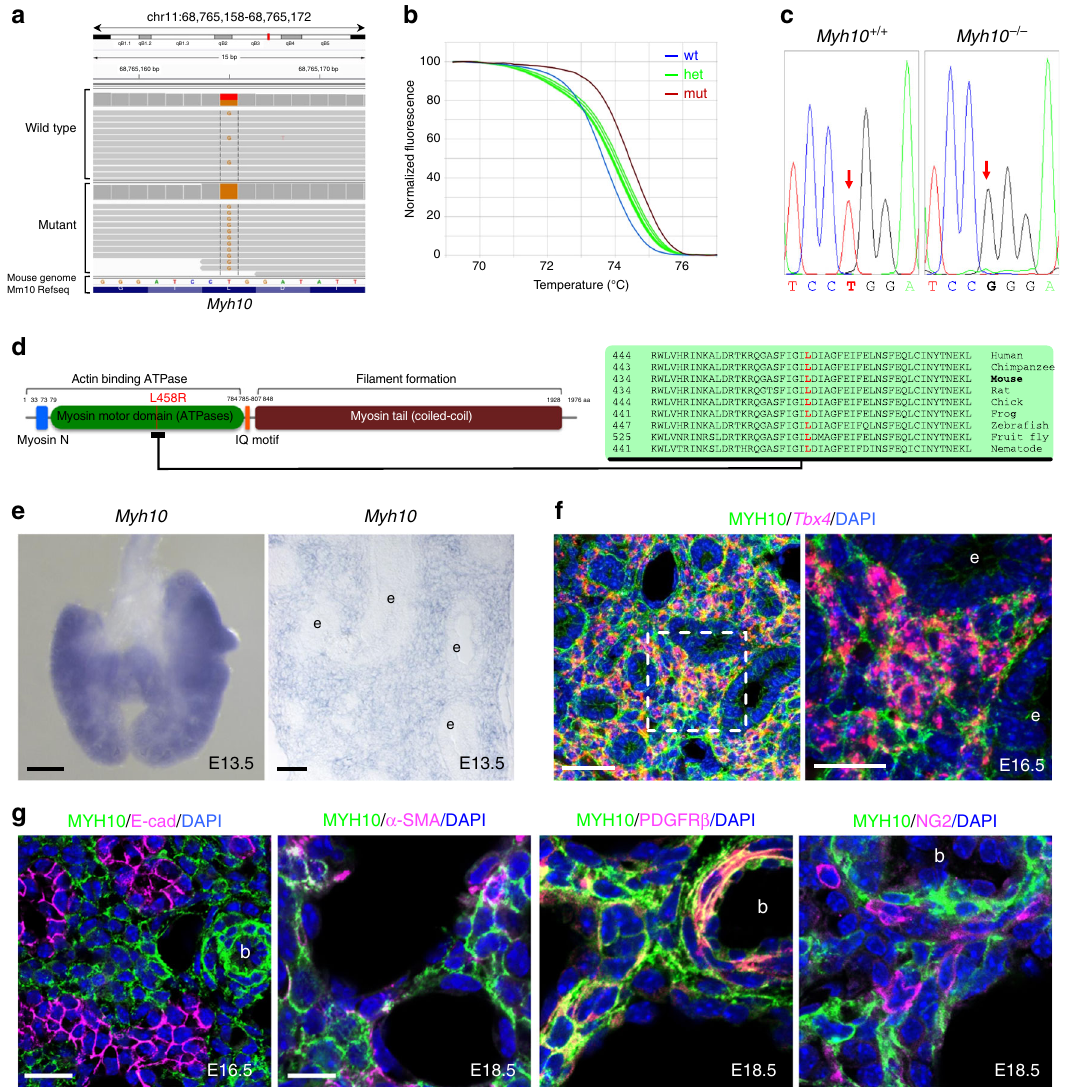
Fig. 2 Isolation of the causative lesion and expression pattern of Myh10 . a Integrative genomics viewer (IGV) snapshot of the c.T1373G mutation in Myh10 (chr 11:68,765,165). b Normalized melting curves showing the Myh10 mutation by high-resolution melting analysis (HRMA). c Chromatogram of two different genotypes of Myh10 by Sanger sequencing. d Schematic diagram of MYH10 protein domains and the relative position of the L458 residue, which is conserved from worms to humans. e In situ hybridization for Myh10 expression in E13.5 whole-mount and on cryosectioned lungs; e epithelium. f Double staining for Tbx4 mRNA (red) and MYH10 protein (green) on E16.5 lung sections; e epithelium. g Immunostaining for MYH10, E-cadherin (marking epithelial cells), α -SMA (marking myo fi broblasts and smooth muscle cells), PDGFR- β (marking myo fi broblasts and smooth muscle cells), and NG2 (marking pericyte-like cells) on E16.5 and E18.5 lung sections; b blood vessel. Scale bars: 200 μ m ( e (left)), 50 μ m ( e (right), f (left)), 20 μ m ( f (right), g (left)), 10 μ m ( g